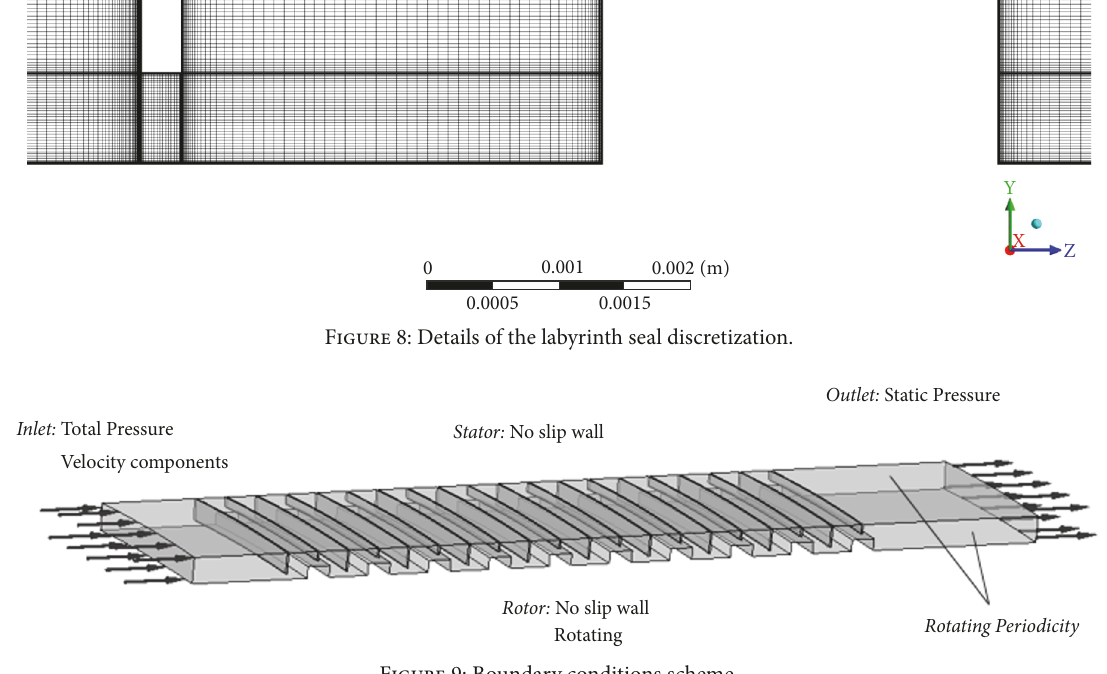
Figure 9: Boundary conditions